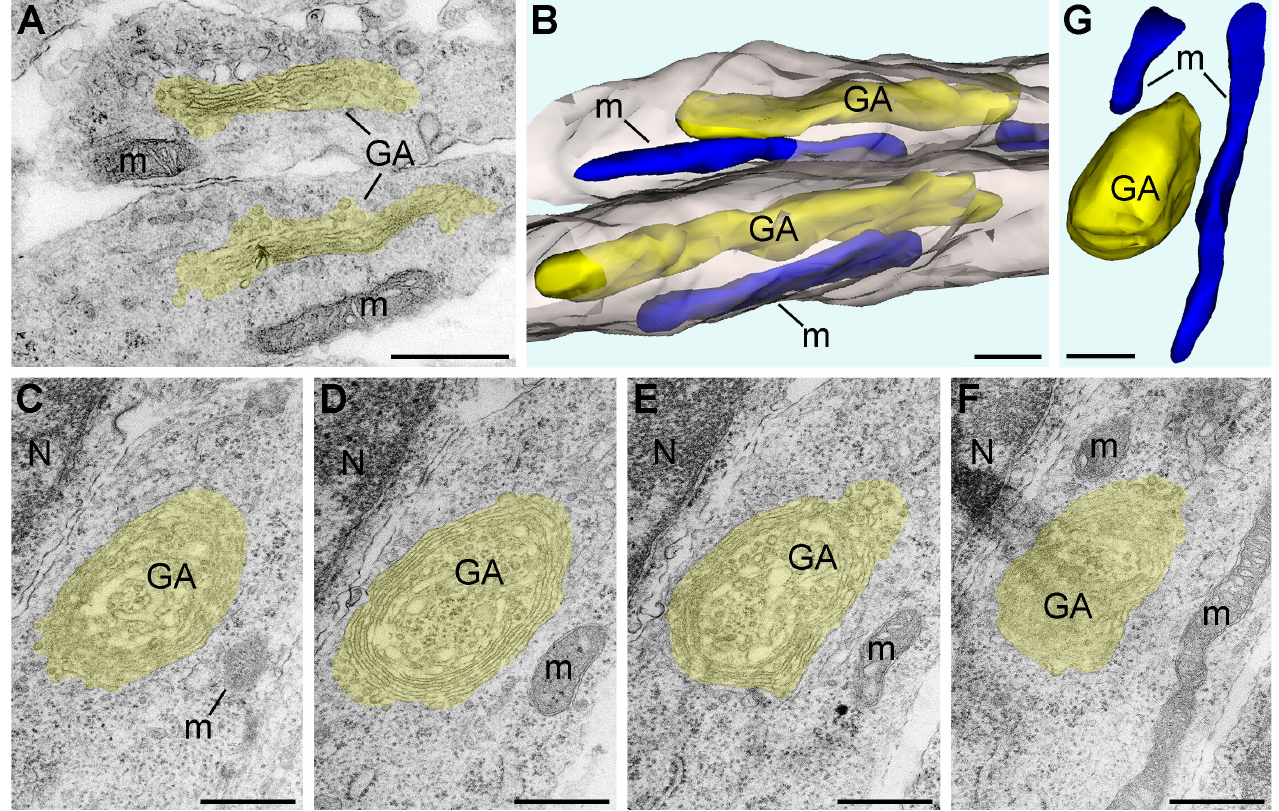
Figure 1. Electron micrographs and 3D reconstructions of GA and mitochondria from E13 mouse embryo cerebral SVZ fixed immediately after decapitation ( A , B ) and after 1 h anoxia ( C – G ). GA including cisternae and vesicles are shown yellow in the electron micrographs ( A , C – F ) and the 3D images ( B , G ). Mitochondria (m) are depicted blue in the 3D images. Two adjacent processes are displayed as semitransparent grey in the 3D image ( B ). In the control brain, both analyzed GA show normal stacks of cisternae and elongated configurations. Serial micrographs ( C – F ) and 3D reconstruction ( G ) demonstrate spherical onion-like shape of GA after 1 h anoxia. Abbreviation: N, cell nucleus. Scale bars, 500